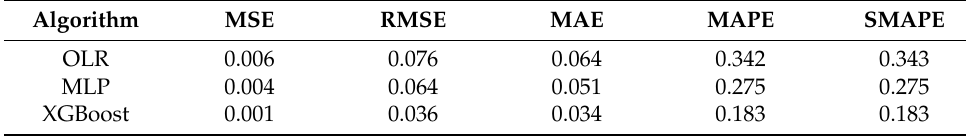
Table 8. Evaluation indexes of each algorithm in